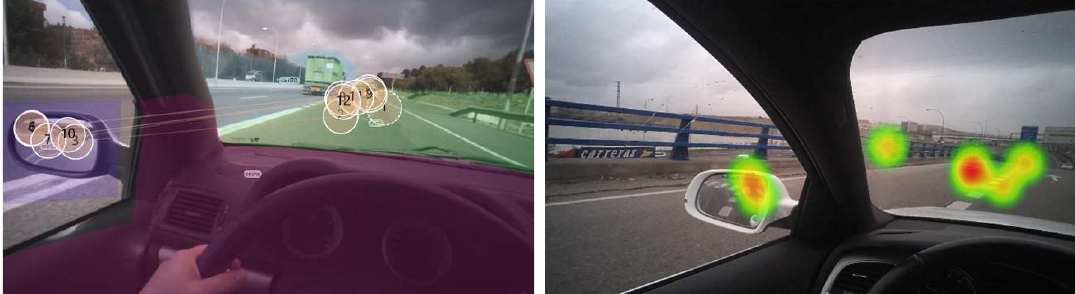
Figure 7. Eye fixations in the areas of interest. Left figure: Fixations numbered in order. Right figure: Heat map.